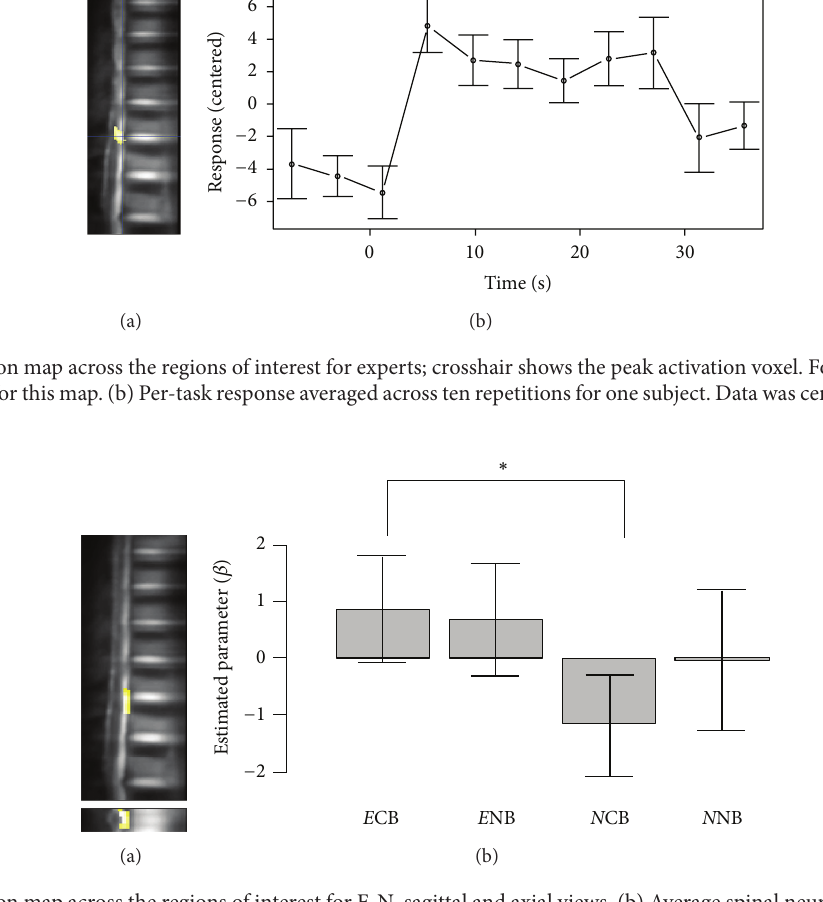
Figure 3: (a) Activation map across the regions of interest for E-N, sagittal and axial views. (b) Average spinal neural activity induced by the task for each session and group masked by the ROI. 𝐸 and 𝑁 , expert and novices; CB and NB denote sessions; error bars indicate standard error of the mean. ∗ denotes 𝑃 < 0.05